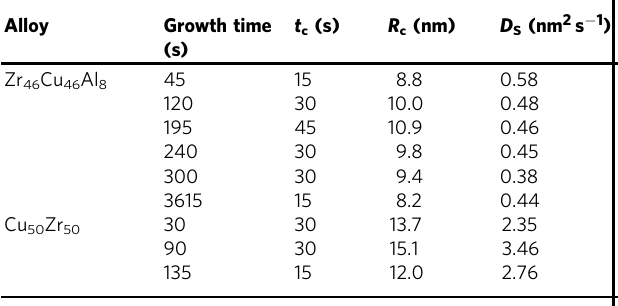
Fig. 4 Variation in surface roughness of MG with higher deposition rate. The Zr 46 Cu 46 Al 8 fi lms were deposited at a rate of 4.16 nm min − 1 on Si 3 N 4 substrate. a The time interval between the data points is 15 s. b The time interval between the data points is 5 s. The error bars indicate the standard deviation of fi ve measurements. Table 1 Calculation of surface diffusion coef fi